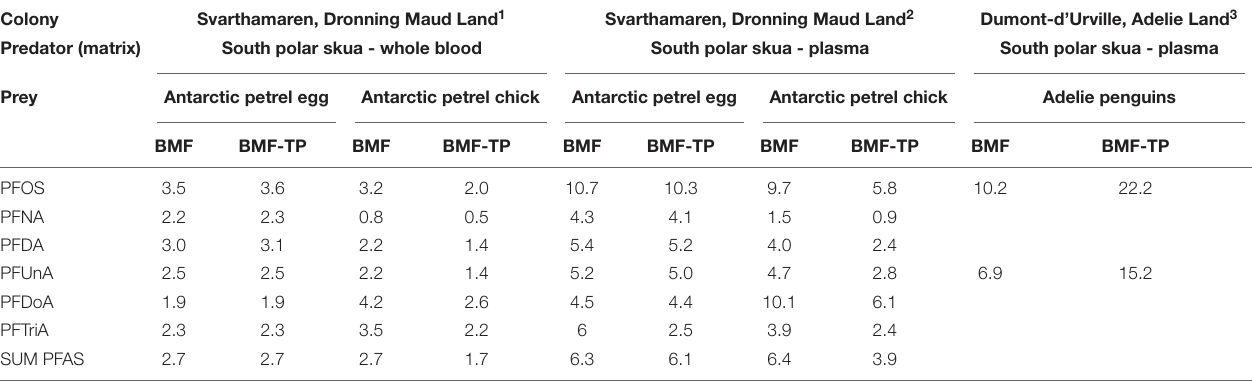
TABLE 3 | Biomagnification factor (BMF) and BMF adjusted to one trophic position (BMF-TP) for PFAS biomagnifying to south polar skuas as a predator at the colony in Svarthamaren (season 2013/2014) and the colony of Dumont d’Urville (season 2011/2012). Colony